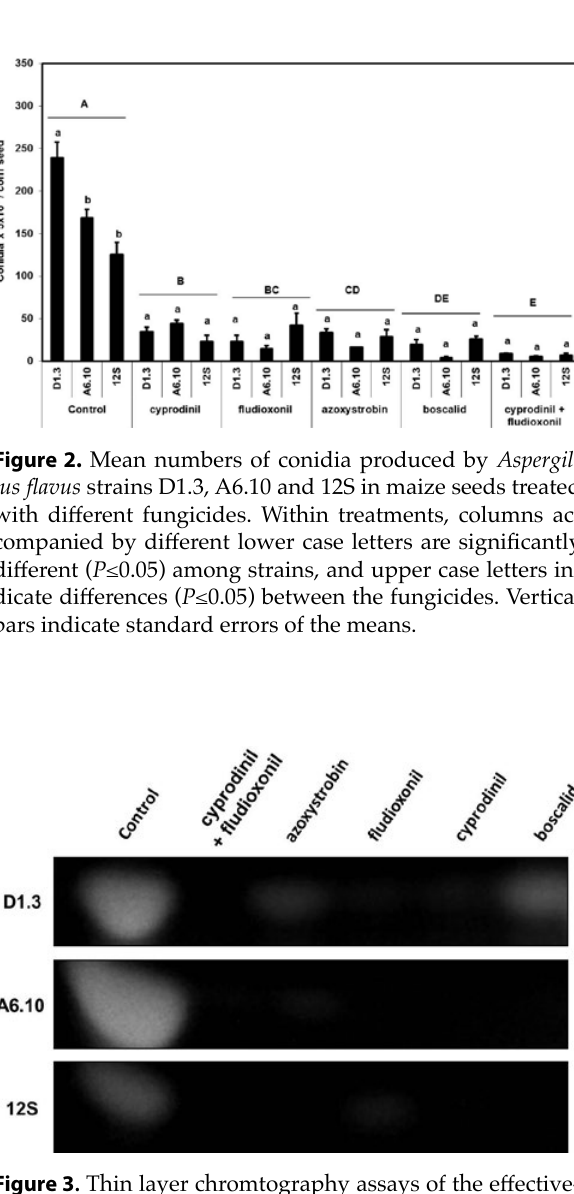
Figure 3 . Thin layer chromtography assays of the effective - ness of five fungicides on aflatoxin production by Aspergil- lus flavus strains D1.3, A6.10 and 12S